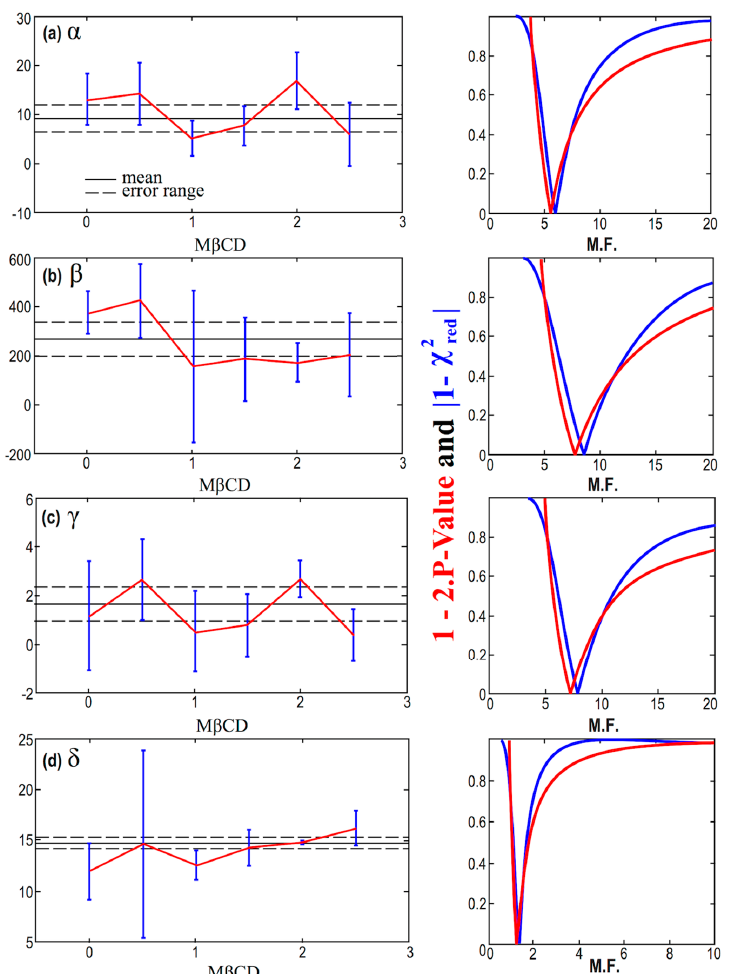
Figure 8. (Left) Diagrams of the modified p -value and reduced chi-square characterizing the linear fitting of the parameters α (a) , β (b) , γ (c) , and δ (d) , with MßCD plotted, as a function of the multiplication factor (M.F.). We identify the M.F. value, for which the corresponding p -value and reduced chi-square are optimized. The goodness of fit is shown using both the modified p -value and reduced chi-square. (Right) Here, the goodness of fit is shown using the unified measure as given by Equation (9) while it is depicted as a function of the signal-to-noise ratio of the slope b/ δ b , characterizing the linear fitting of the parameters with MßCD; (note: Both the ratio b/ δ b and the goodness of fitting are plotted as functions of the multiplication factor (M.F.)). The cases of the parameter α and γ have the optimal values of the p -value and reduced chi-square for │ b/ δ b │ < 1, so that the hypothesis of being dependent on MßCD is rejected. On the other hand, the cases of the parameter β and δ have the optimal values of the p -value and reduced chi-square for │ b/ δ b │ >> 1, thus, the hypothesis of MßCD dependence is accepted. Figure 7. (Left column) Diagrams of the values of the parameters α (a) , β (b) , γ (c) , and δ (d) , plotted against the concentration of MßCD, after accounting for the optimal multiplication factor (M.F.). (Right column) Corresponding diagrams of the modified p -value and reduced chi-square characterizing fitting of the parameters α , β , γ , and δ , modeled as constants with MßCD, and plotted as a function of the multiplication factor (M.F.)